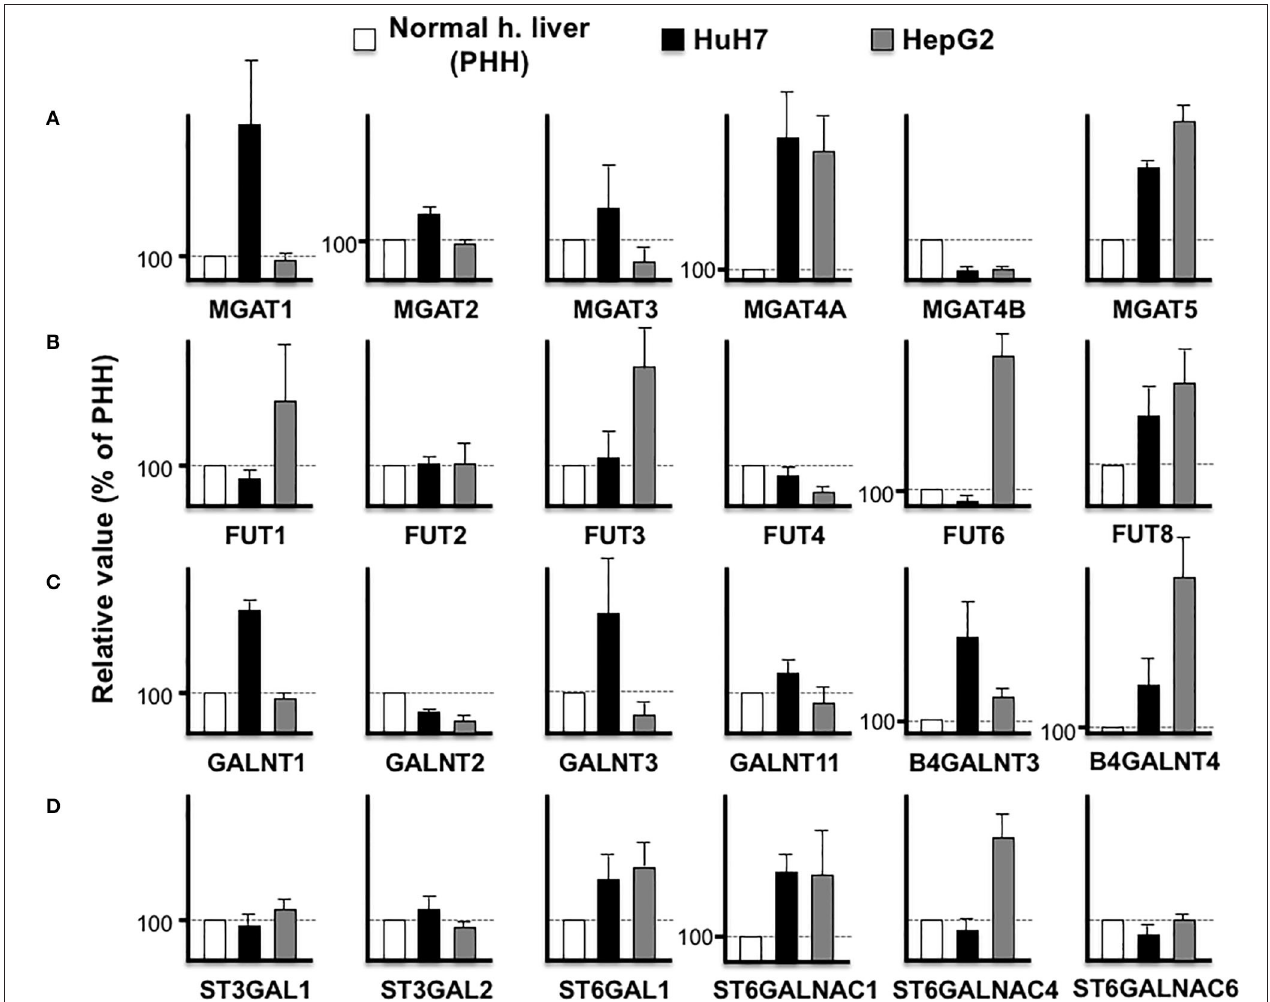
FIGURE 4 | Comparison of glycosyltransferase expression among hepatic cells. RPKM obtained from PHH (white), HuH7 (black), and HepG2 (gray) were compared in N-acetylglucosaminyltransferases (A) , fucosyltransferases (B) , N-acetylgalactosaminyltransferases (C) , and sialyltransferases (D) . Average of four measurements is indicated and error bars shows standard